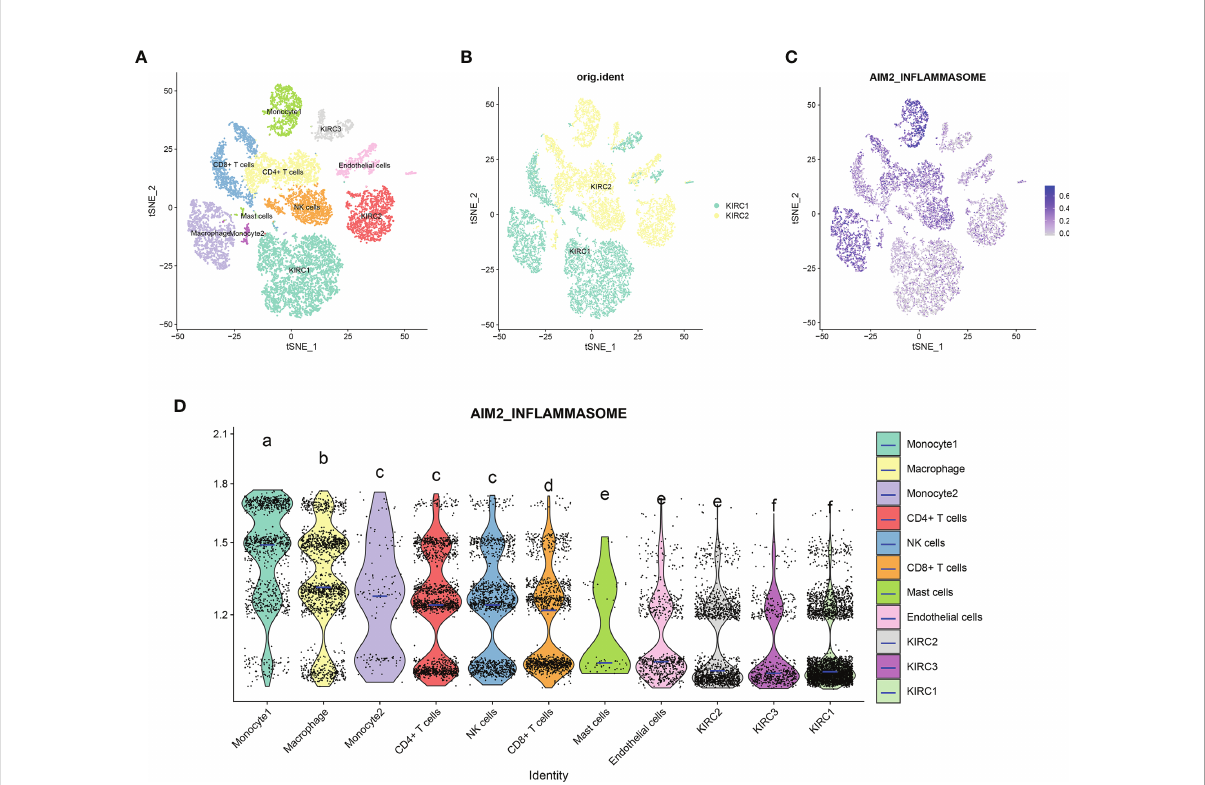
FIGURE 13 Single-cell transcriptomic atlas of Kidney renal clear cell carcinoma (KIRC). (A) A tSEN plot of KIRC samples with 11 distinct cell types. (B) A tSEN plot of KIRC from two different samples. (C) A tSEN plot of AIM2 in fl ammasomes scores in different cell types. (D) Comparison of AIM2 in fl ammasomes scores in different KIRC tumor microenvironment cells. The blue horizontal line on the violin plot indicates the median AIM2 in fl ammasomes score. The letters at the top indicate whether there is a statistical difference between the two cells. Different letters indicate that the difference is statistically signi fi cant (Student ’ s